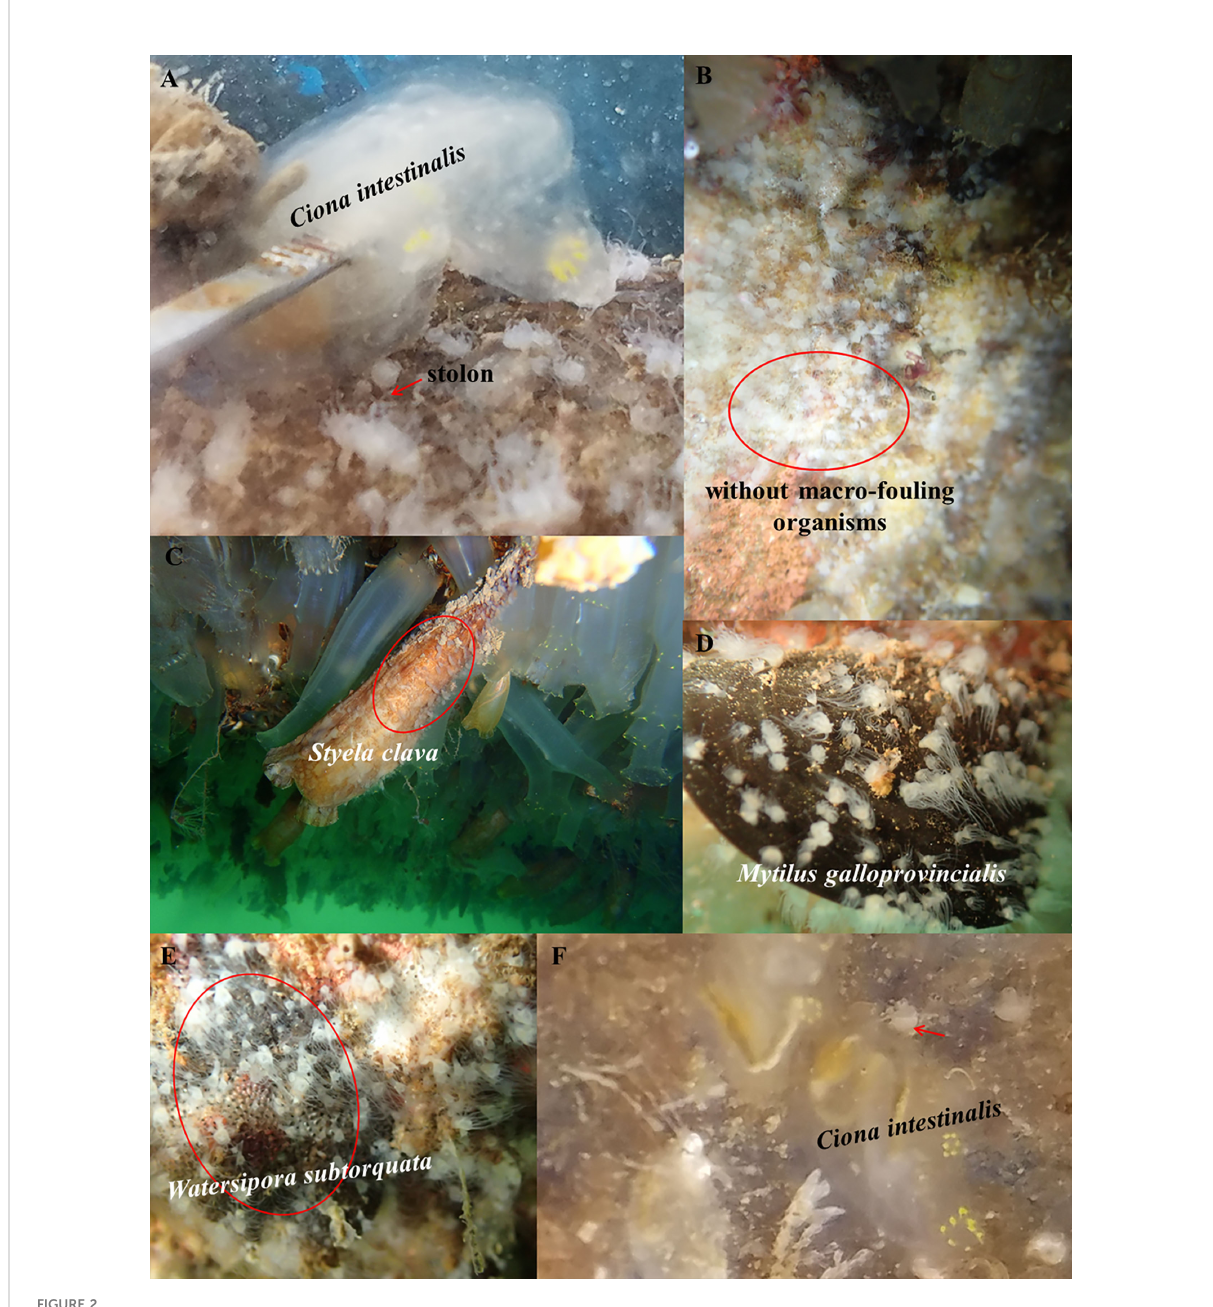
FIGURE 2 Aurelia coerulea and Nemopilema nomurai polyps in the fi eld. (A) An A. coerulea polyp on a plate hanging in Jiaozhou Bay, China extending to the unoccupied area by an ascidian Ciona intestinalis via a stolon (red arrow) for proliferation. (B) A. coerulea polyps settled on some areas without macro-fouling organisms (red circles) on the undersurface of the dock “ Haiou ” in Jiaozhou Bay, China. (C-E) Many A. coerulea polyps growing on the surfaces of an ascidian Styela clava (C) , a mussel Mytilus galloprovincialis (D) , and a bryozoan Watersipora subtorquata colony (E) on the undersurface of the dock “ Haiou ” in Jiaozhou Bay, China. (F) A</ca> N. nomurai polyp (red arrow) on a plate hanging in Jiaozhou Bay, China being invaded by an ascidian C. intestinalis . These pictures were photographed with an Olympus waterproof